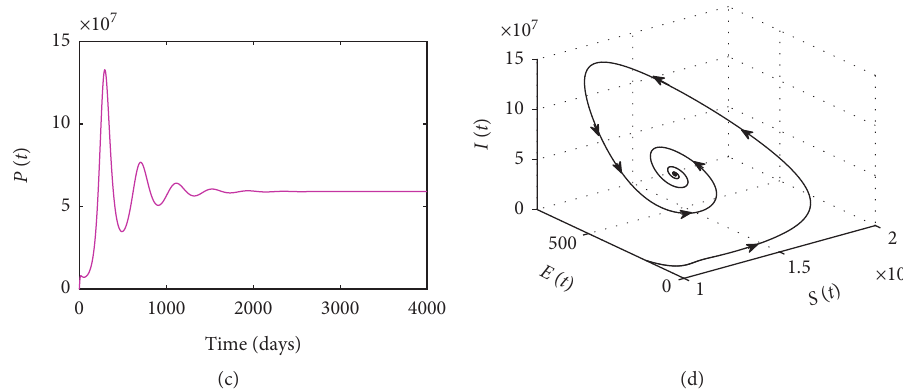
Figure 5: Numerical results of system (1) depicting the persistence of the disease of R Parameter values used to construct the simulations are in Table 1, with p � 0 . 01, κ � ϵ � 0 . 1, and f � 0 . 01, leading to R